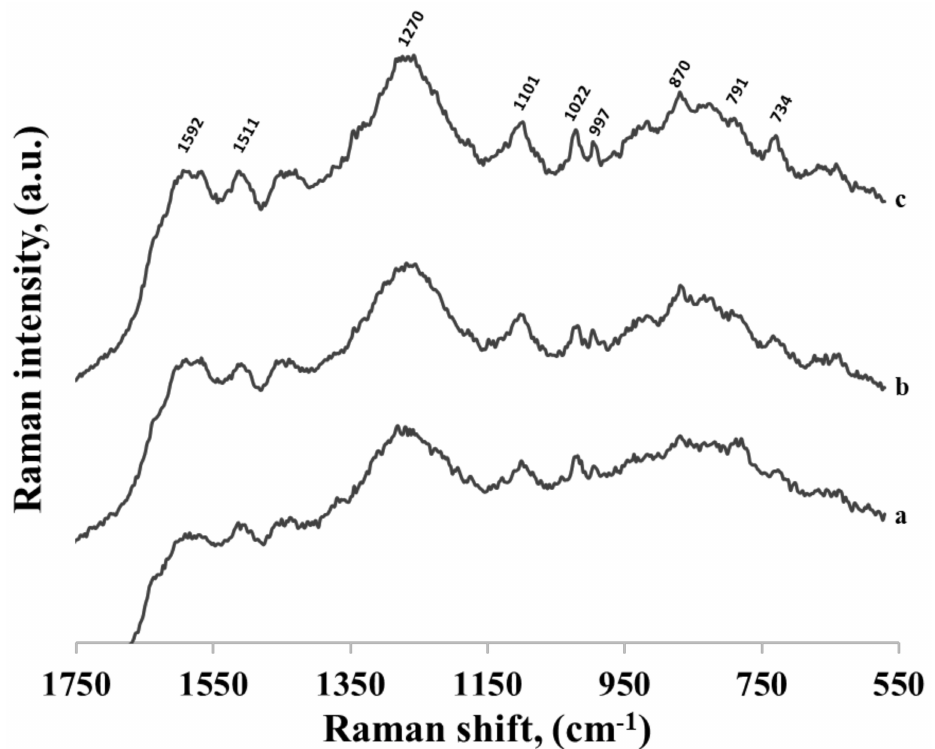
Figure12. SERSspectraofthreedi ff erentthiolatedsingle-strandedDNAadsorbedongoldnanoparticles. Every DNA contains 16 bases: 15 cytosines and one adenine, however the adenine was located in three di ff erent positions: (a) at the 5’ end as the last base in the chain, (b) in the middle of the chain between the 7th and 8th cytosines and (c) at the 3’ end between the hexanethiol moiety and the cytosine chain. 3. Materials and